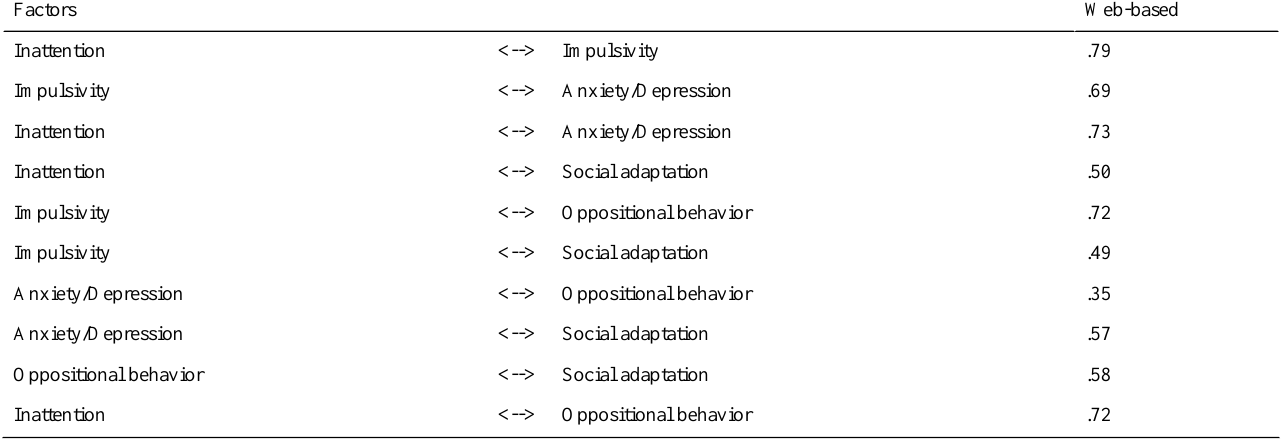
Table 6. Intercorrelations between the WURS-k factors (latent constructs) in the Web-based